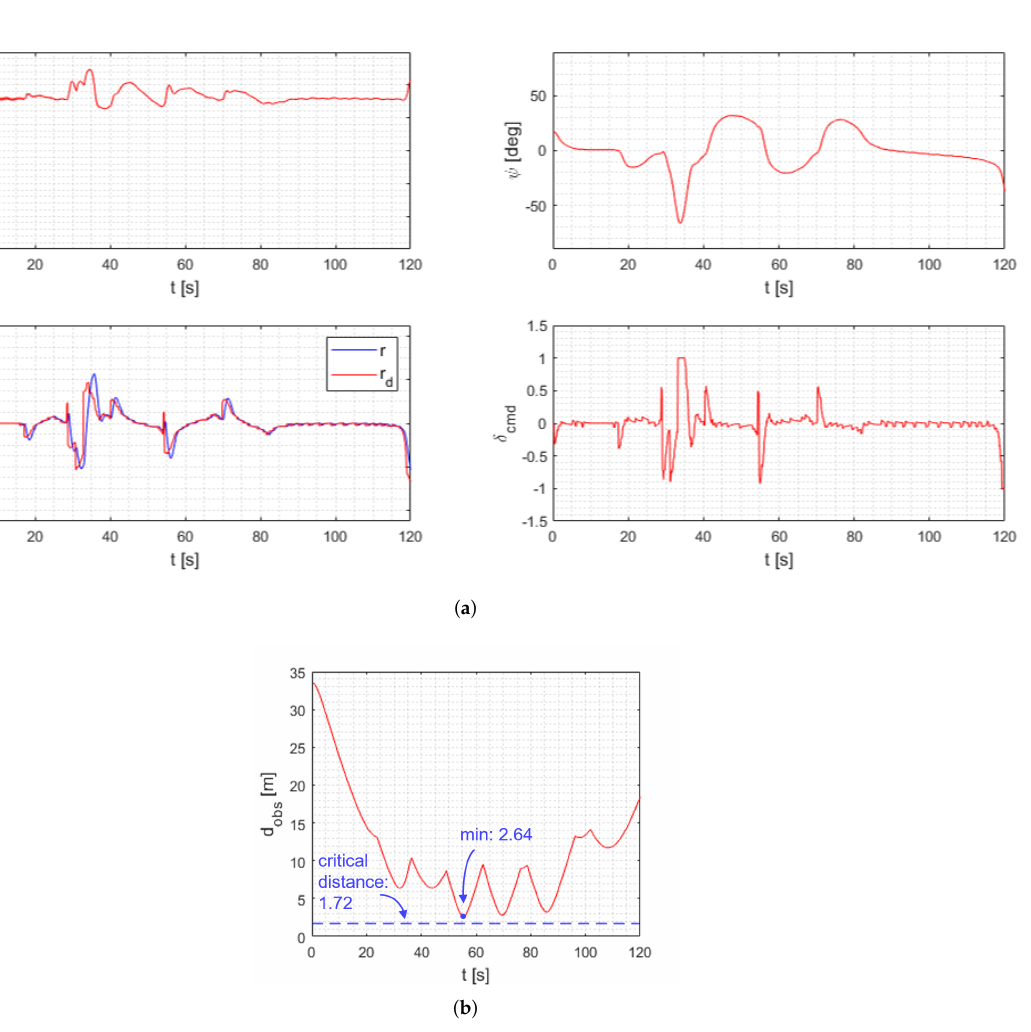
Figure 13. Variables measured in the scenario with multiple fixed obstacles. ( a ) State variables of the USV; ( b ) distance to the closest